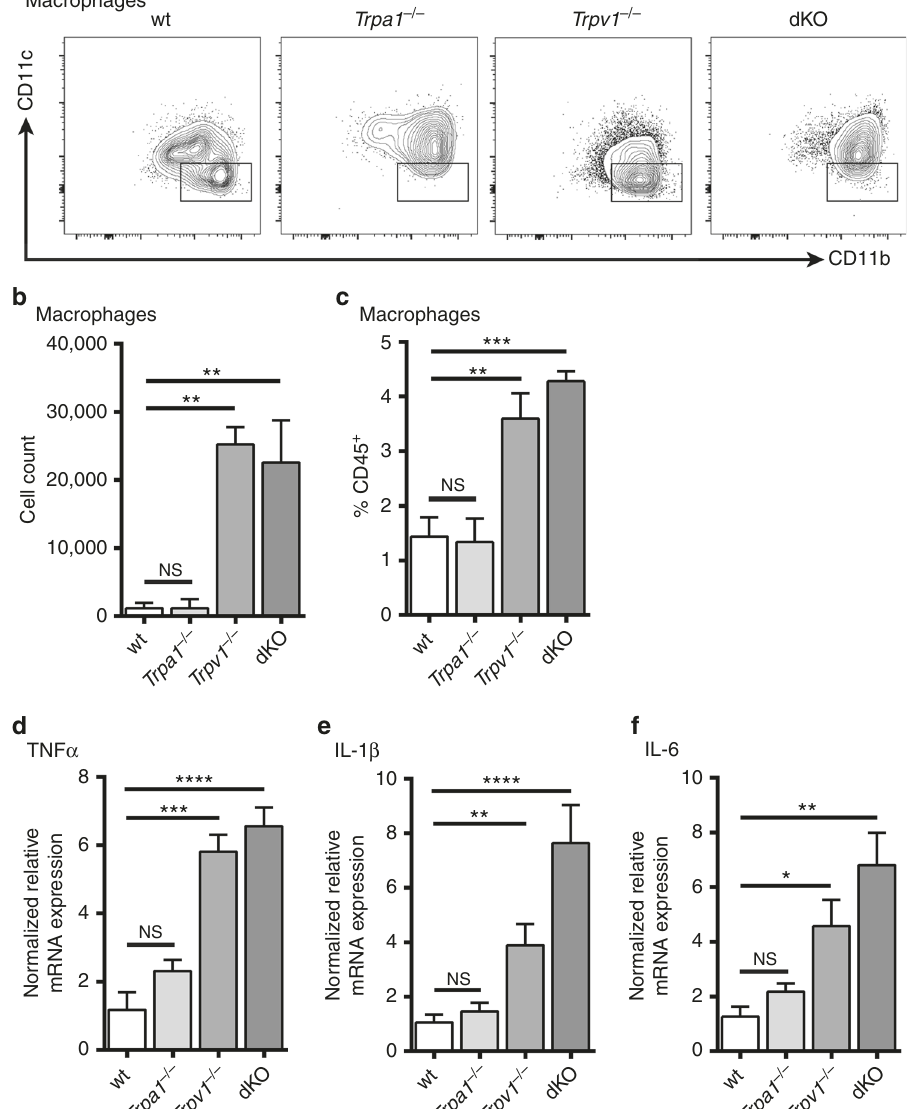
Fig. 7 TRPV1 de fi ciency promotes the function of dermal macrophages. a Representative FACS plots of macrophages in the ear preparations isolated from wt, Trpa1 − / − , Trpv1 − / − , and Trpa1 − / − / Trpv1 − / − dKO mice. Macrophages were de fi ned as I-A b-lo/- F4/80 + CD11b + CD11c - ; b , c Quanti fi cation of the number ( b ) and the percentage ( c ) of macrophages based on fl ow cytometry analysis. n = 3. Data are presented as mean ± SEM. NS, not signi fi cant. Asterisks indicate statistical signi fi cance. ** p < 0.01; *** p < 0.001, ANOVA; d – f Expression of proin fl ammatory cytokines TNF ɑ ( d ), IL-1 β ( e ) and IL-6 ( f ), in the SADBE-treated ear preparations of wt, Trpa1 − / − , Trpv1 − / − , and Trpa1 − / − / Trpv1 − / − dKO mice. Data are presented as mean ± SEM. NS, not signi fi cant. Asterisks indicate statistical signi fi cance. * p < 0.05; ** p < 0.01; *** p < 0.001; **** p < 0.0001,